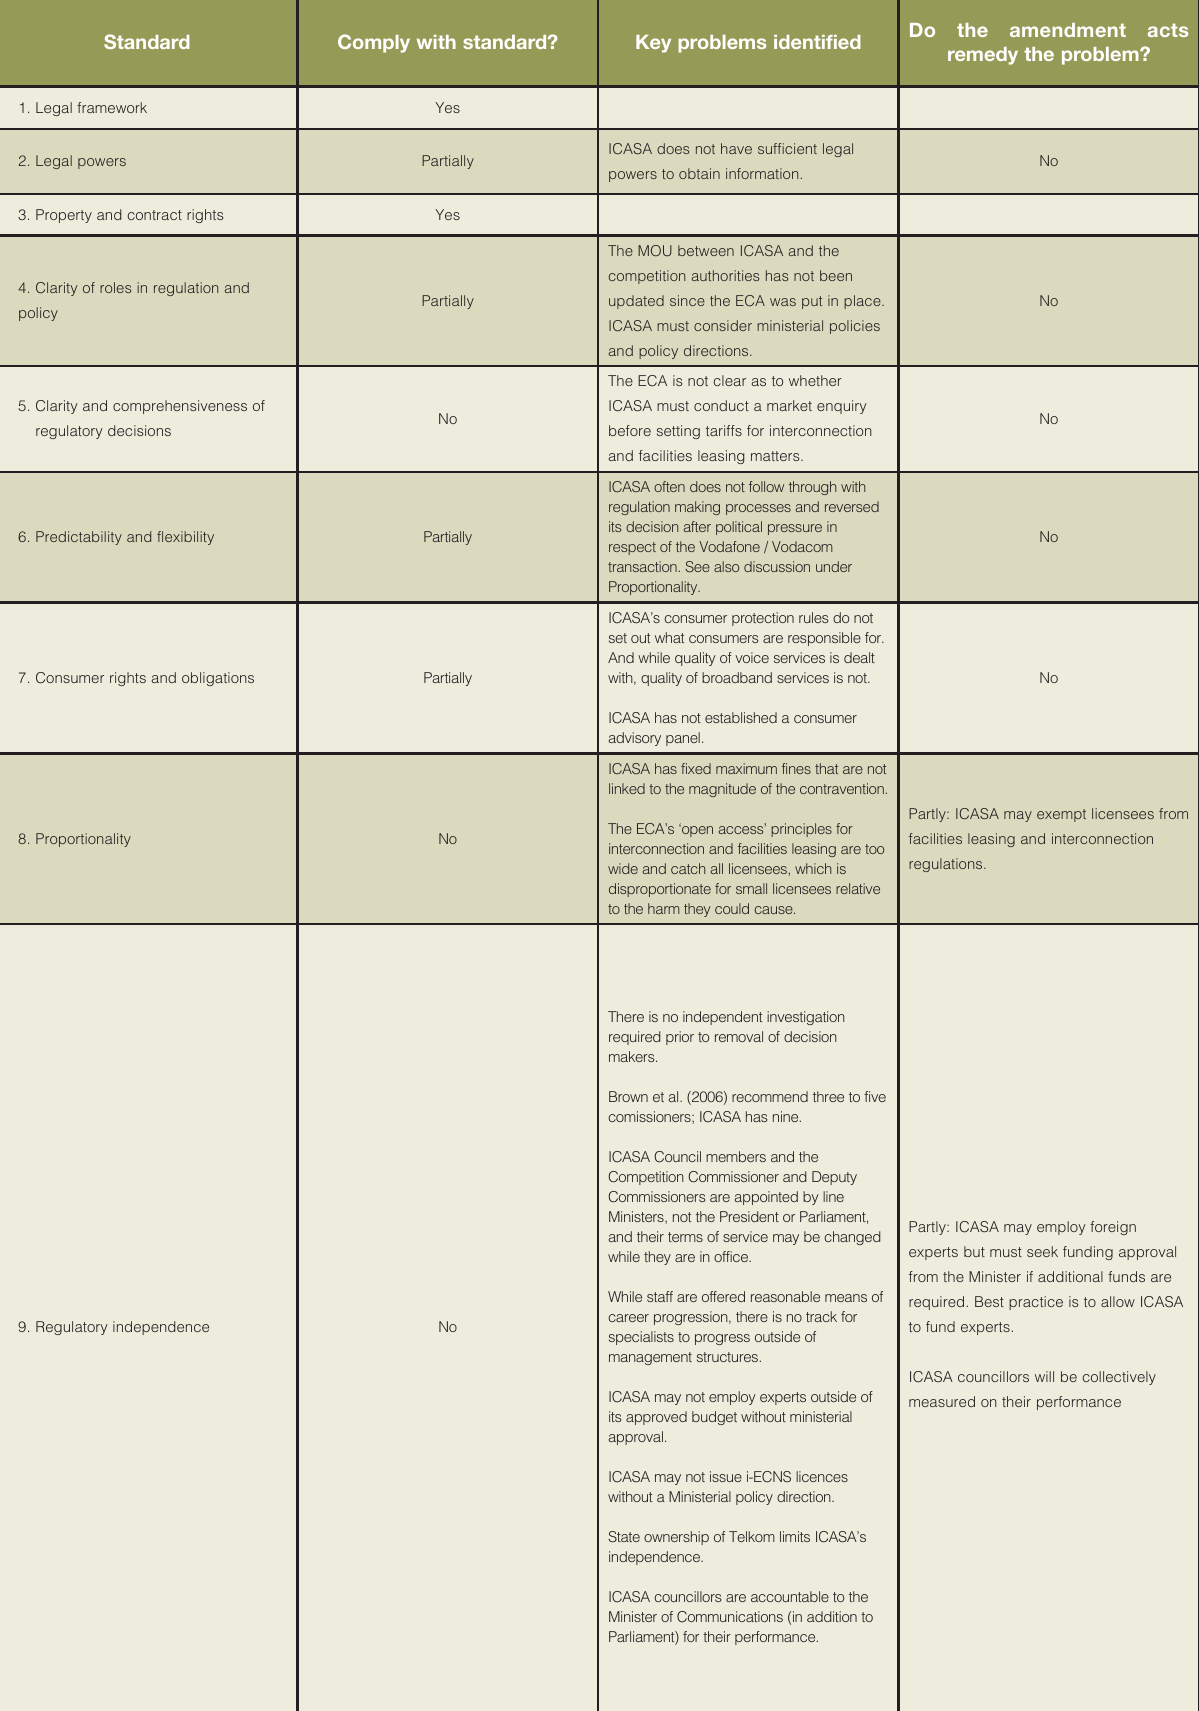
TABLE 1: SUMMARY OF ASSESSMENT OF REGULATORY GOVERNANCE FOR THE ECONOMIC REGULATION OF THE TELECOMMUNICATIONS SECTOR IN SOUTH